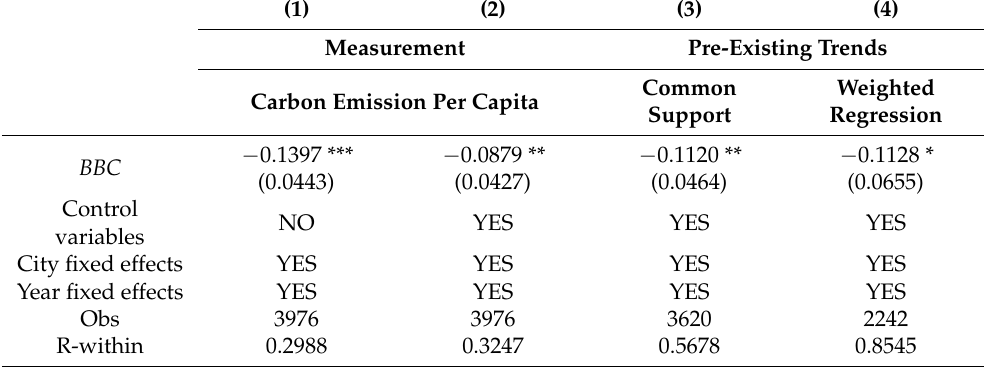
Table 4. Robustness test